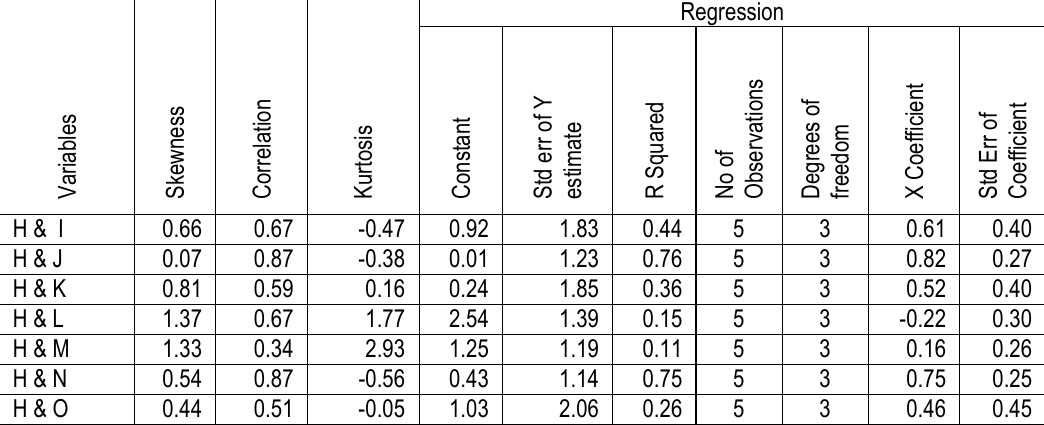
Table 7. Relationship of Admission with other Variables